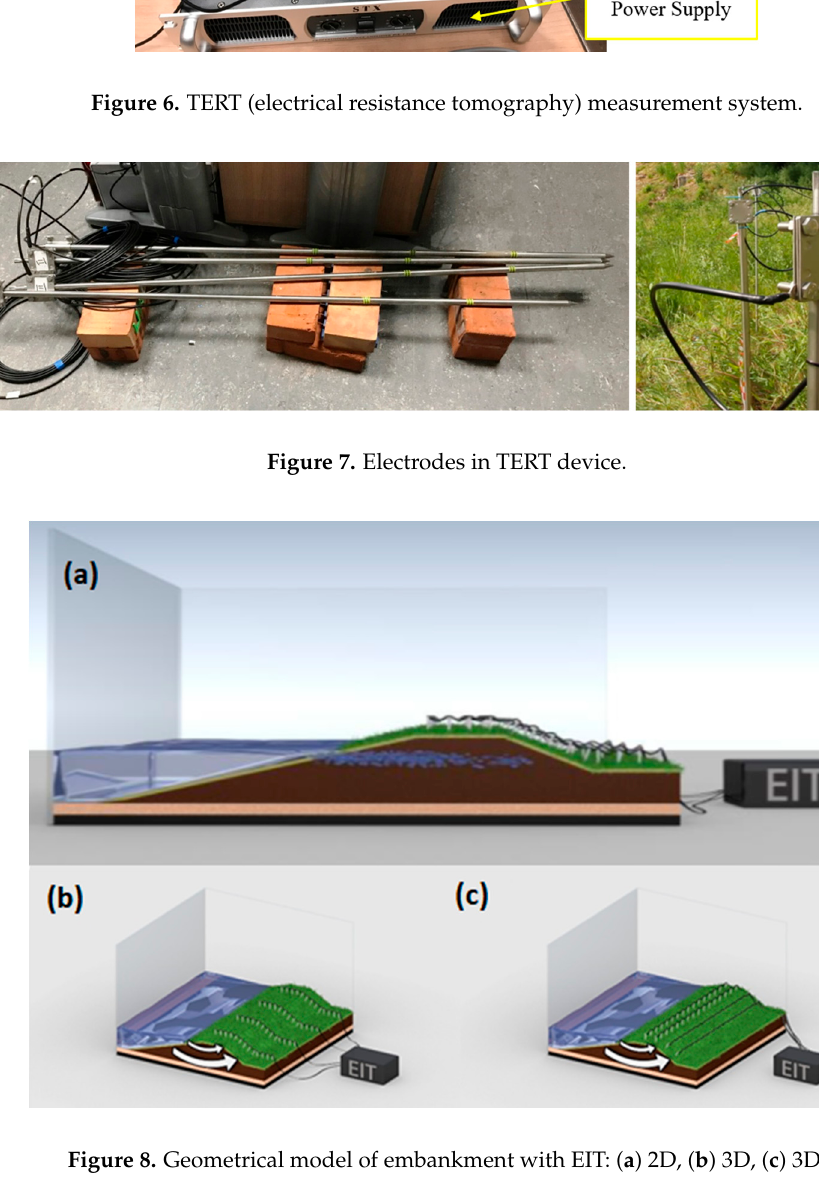
Figure 8. Geometrical model of embankment with EIT: ( a ) 2D, ( b ) 3D, ( c ) 3D.